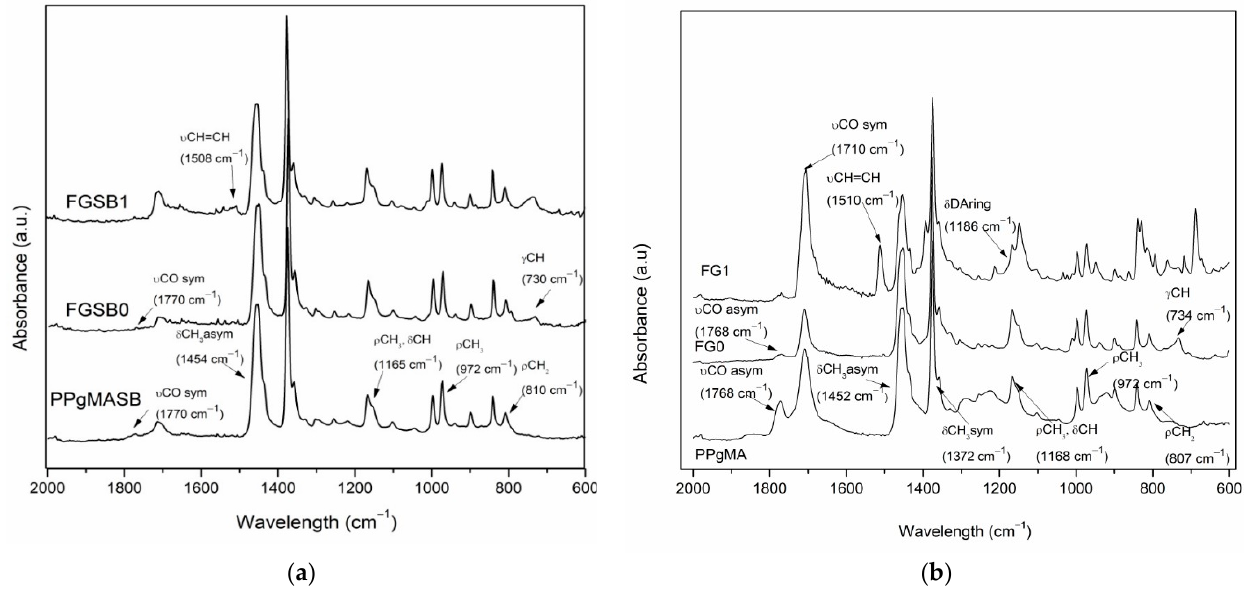
Figure 1. FTIR spectra of PPgMASB and its derivatives ( a ); PPgMA and its derivatives ( b ).